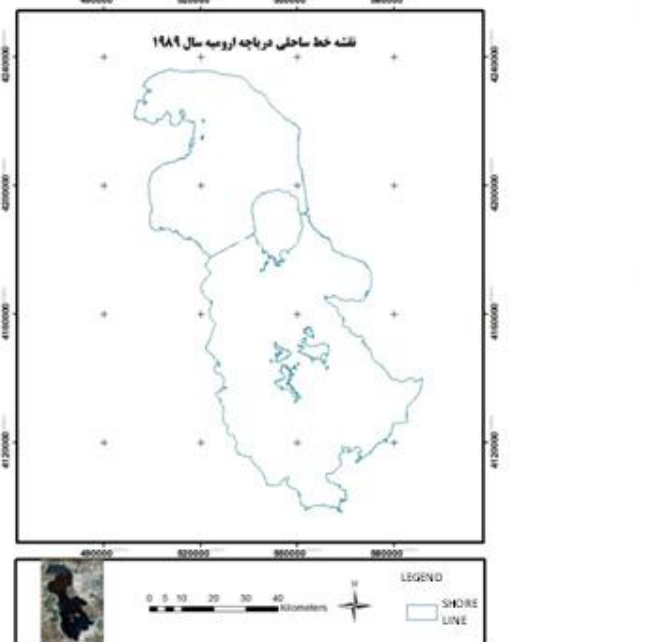
Figure 9: Urmia lake shoreline in 1989